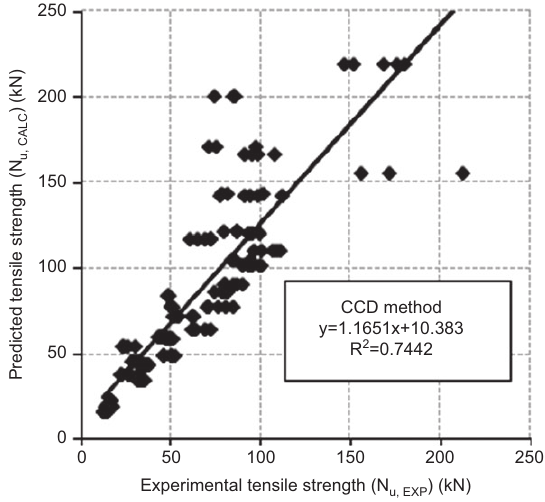
Figure 8 CCD method calculation results for single anchors.